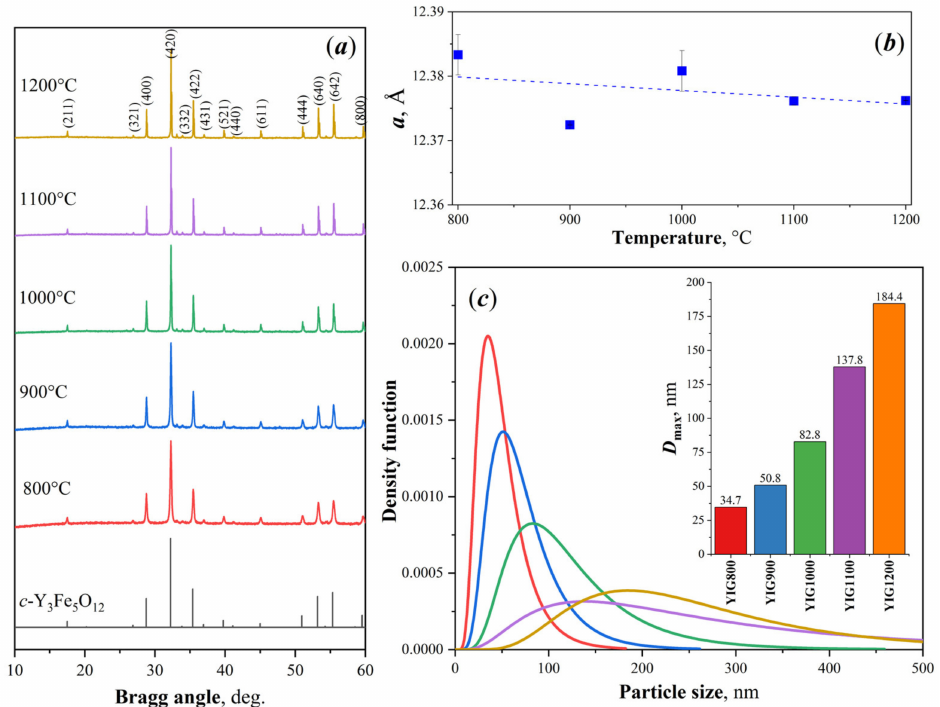
Figure 2. XRD patterns of the obtained heat-treated particles ( a ), lattice constant ( b ), particle’s size distributions from SEM ( c ), and D max -crystallite sizes